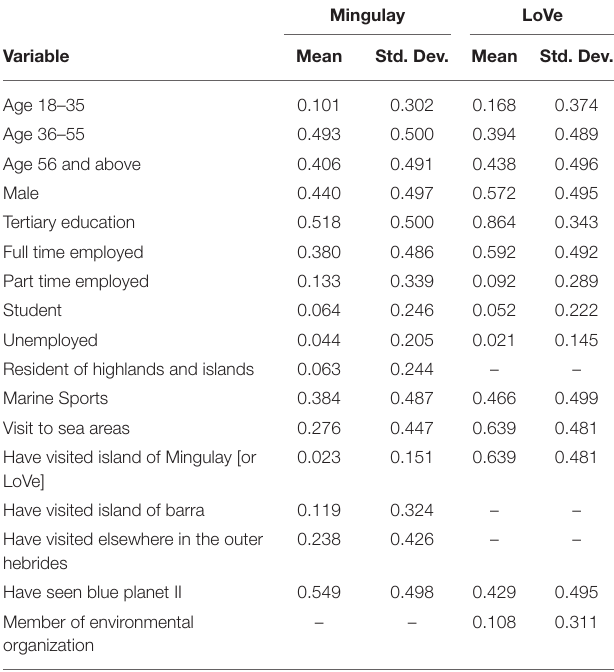
TABLE 2 | Summary